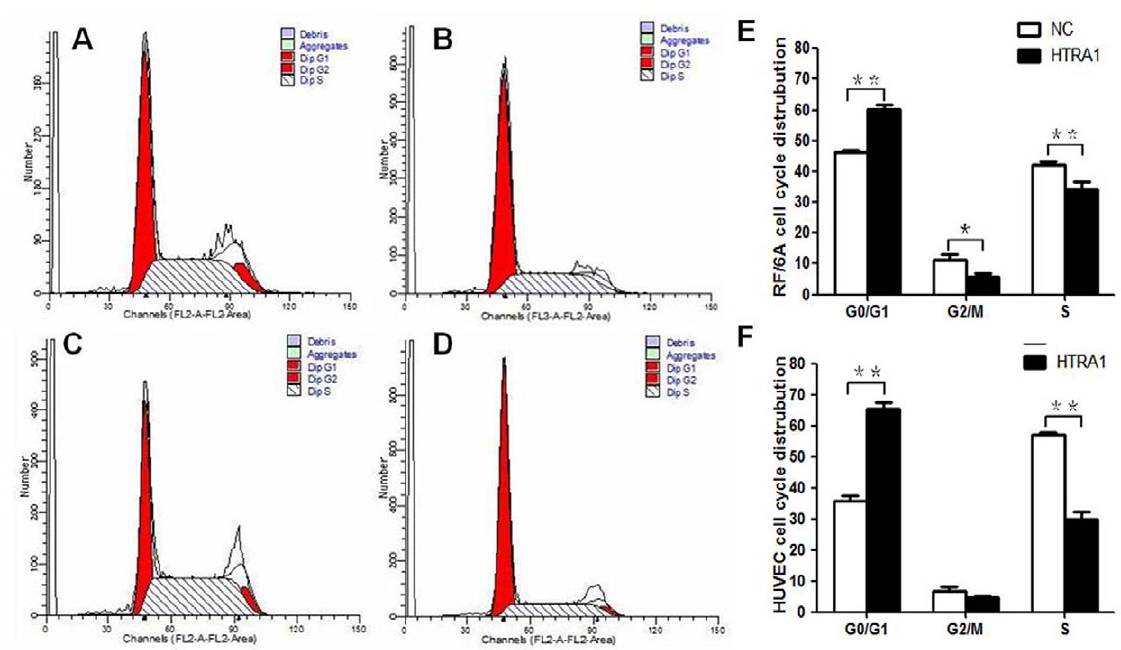
Figure 4. Effect of HTRA1 on the cell cycles of RF/6A cells and HUVECs. Flow cytometric analysis demonstrated that the fraction of G1-phase cells increased and the proportion of S-phase cells decreased in the RF/6A cells (A and B) and HUVECs (C and D) after increased expression of HTRA1. The proportions of G0/G1, G2, and S phase cells decreased in HTRA1-transfected RF/6A cells compared to control RF/6A cells transduced with the lentiviral vector (E, *p , 0.05, **p , 0.01). The proportions of G0/G1-and S-phase cells were decreased in HTRA1-transfected HUVECs compared with the control HUVECs transduced with the lentiviral vector (F, **p , 0.01).